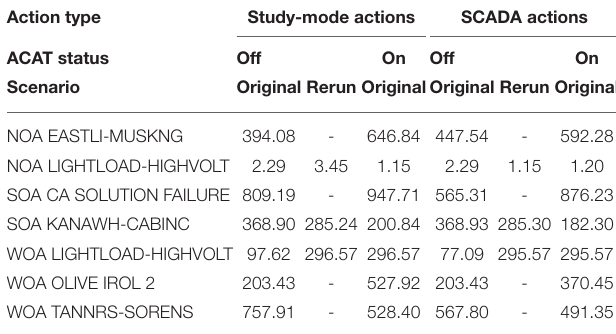
TABLE 5 | Two Way ANOVA to predict completion time from ACAT and difficulty.